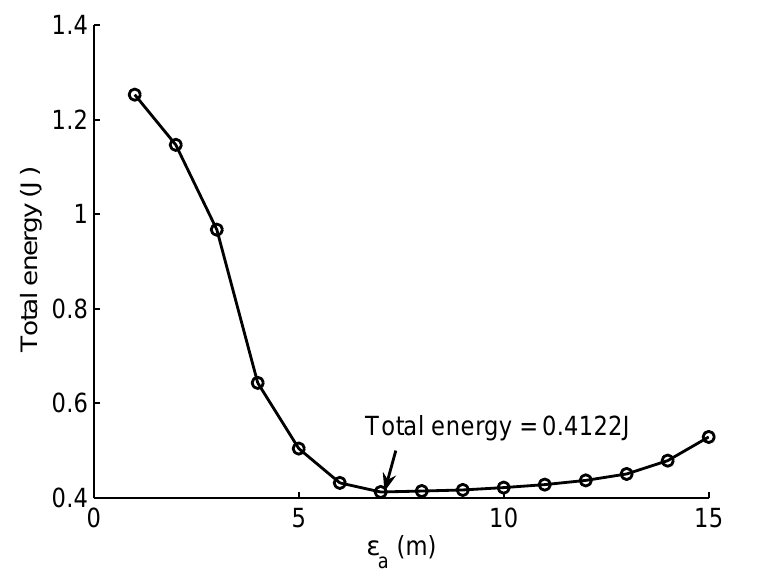
Figure 12 . Total energy consumption of WSN vs. localization error upper bound.